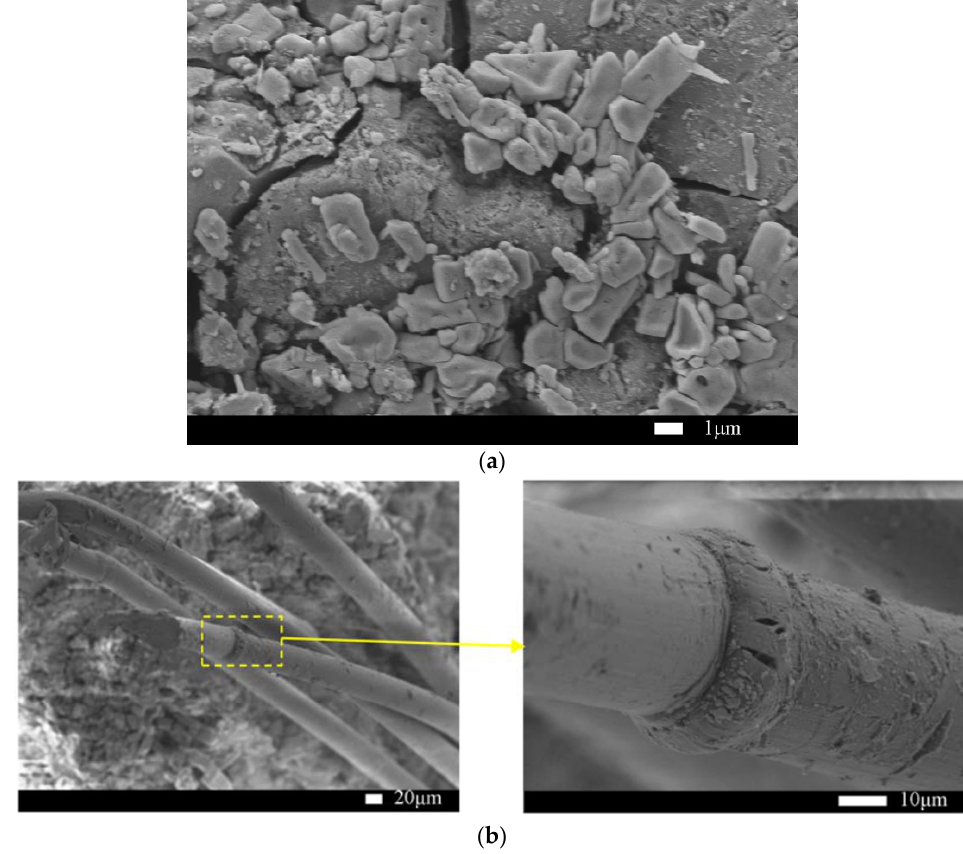
Figure 13. ( a ) The matrix and ( b ) its bonding with fibers for HDMC with 7-day water